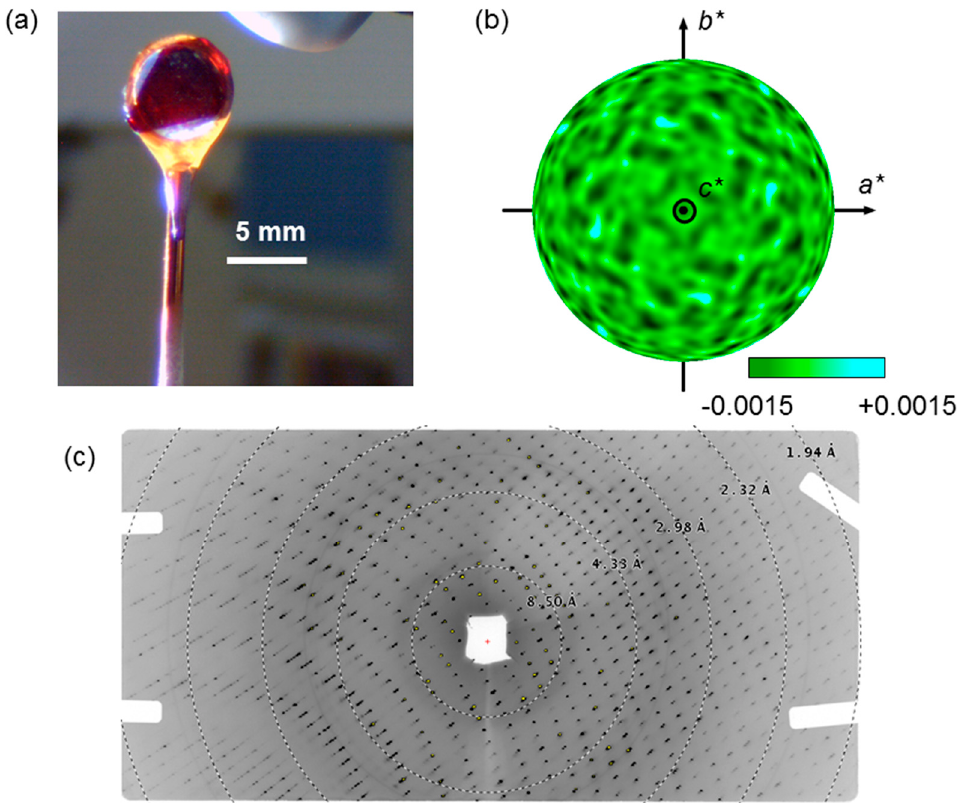
Figure 8. X-ray fluorescent holography (XFH) measurement for the COHbA crystal. ( a ) Crystal setup for data collection. Our largest COHbA crystal of about 7.5 × 6 × 3 mm in size (~130 mm 3 ) was mounted on a customized loop made by a polyimide film (0.125 mm thickness) with a copper wire (1.2 mm diameter), and cooled to 100 K by nitrogen gas flow; ( b ) Typical hologram pattern of the COHbA crystal (excited by 7.25 keV X-ray photons), represented as a stereographic projection of an interference pattern in the reciprocal space ( a* , b* , c* ) after applying a Gaussian low path spatial filter [13]; ( c ) An X-ray diffraction pattern of the COHbA crystal used for the XFH measurement. The measurement was carried out using an imaging plate of 2048 × 4020 pixels. The wavelength of X-ray was 1.127 Å.